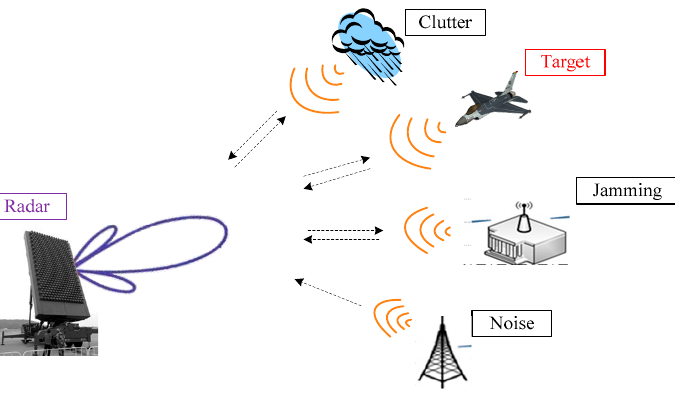
Figure 3. A schematic of RTD in a complex scene.